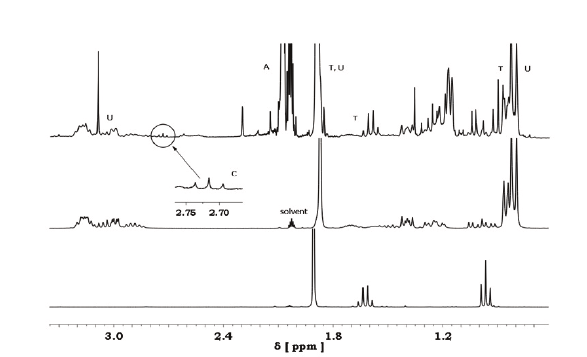
Figure 2: 1H NMR spectra of Seal&Protect (upper), UDMA (middle) and TMPTMA (lower run); aliphatics absorption range; A –